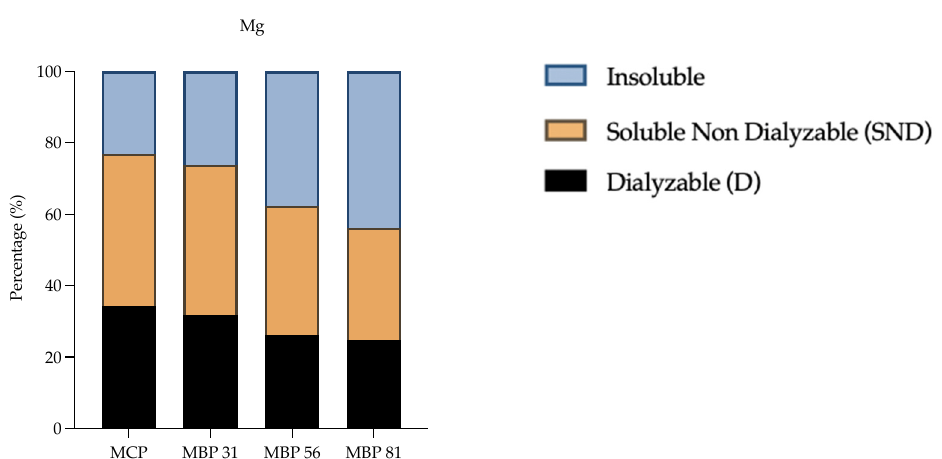
Figure 3. Percentage (%) bioaccessibility of dialyzable (D), soluble non-dialyzable (SND), and insoluble minerals during in vitro digestion in the formulated composite porridges.